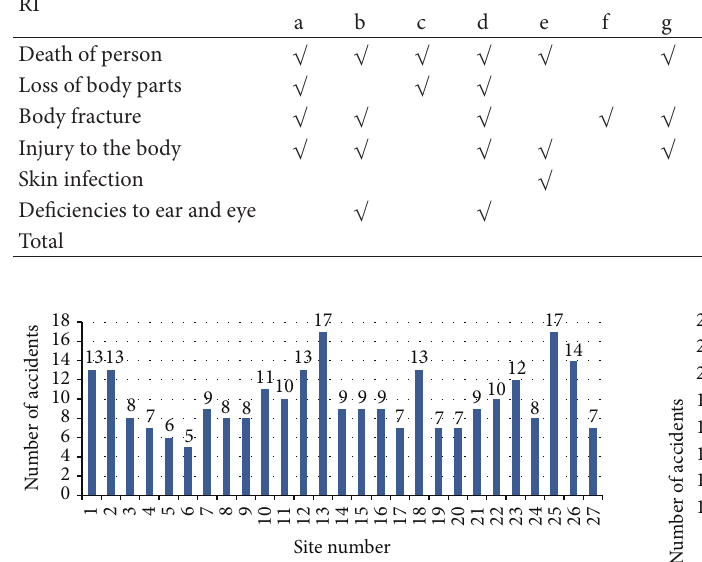
Figure 2: Number of accidents in small construction sites.